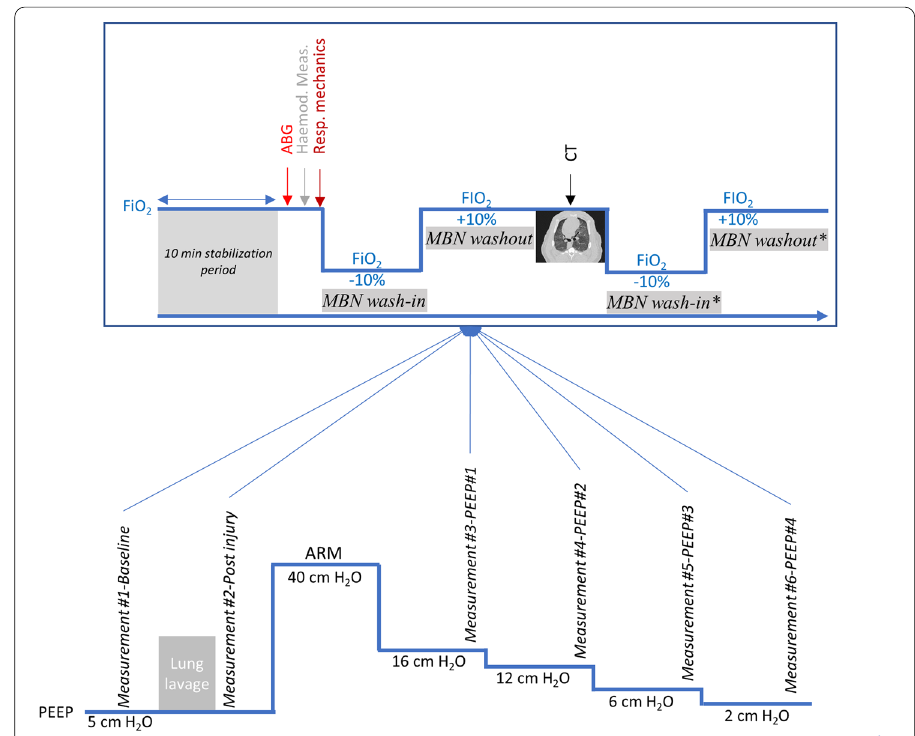
Fig. 1 Experimental protocol. ABG arterial blood gas, ARM alveolar recruitment maneuver, CT computed tomography, FiO 2 fraction of inspired oxygen, Hemod . Meas . hemodynamic measurements, MBN multiple breath nitrogen, PEEP positive end‑expiratory pressure; Resp. mechanics respiratory mechanics measurements. * refers to MBNW replicates performed in all experimental conditions on 5 pigs of the